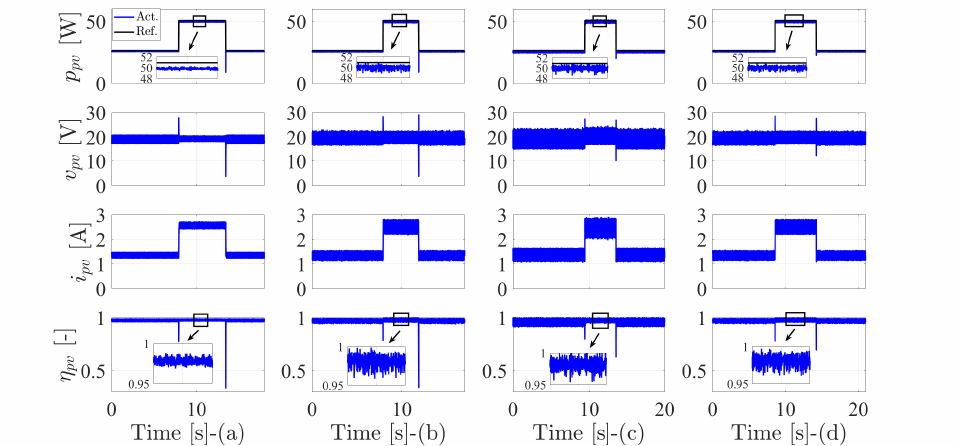
Figure 7. The performance of the MPPT techniques under step response of the PV power: ( a ) Fixed switching MPPT-based digital observer. ( b ) MPPT-based FS-MPC. ( c ) The first proposed DMPPT